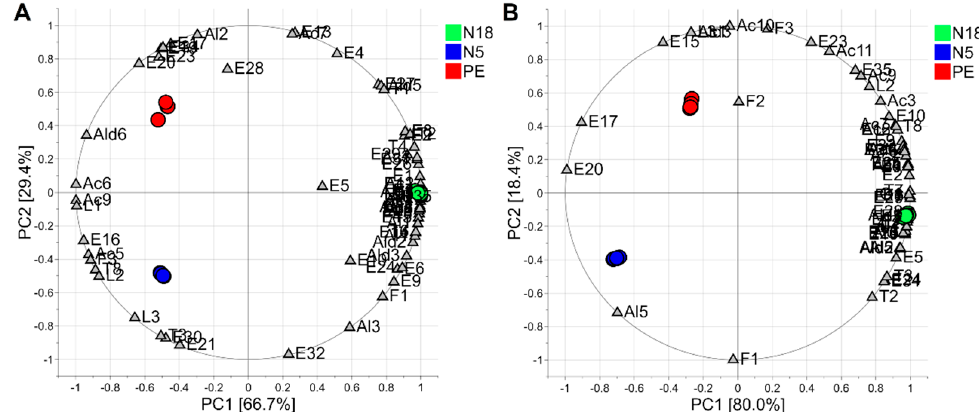
Figure 1. Biplots of the PCA models for the two cultivars: Elide (R2 = 96.1%, panel ( A )) and Sabrina (R2 = 98.4%, panel ( B )); VOCs are reported as grey triangles.